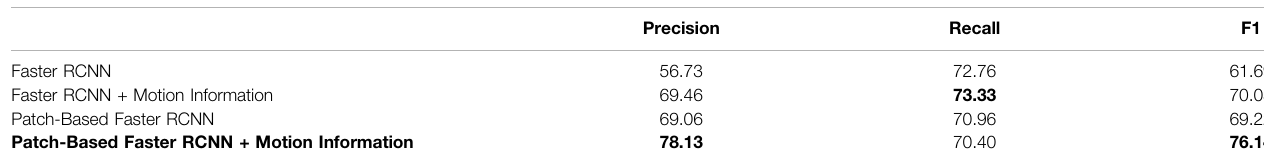
TABLE 1 | Ablation studies.